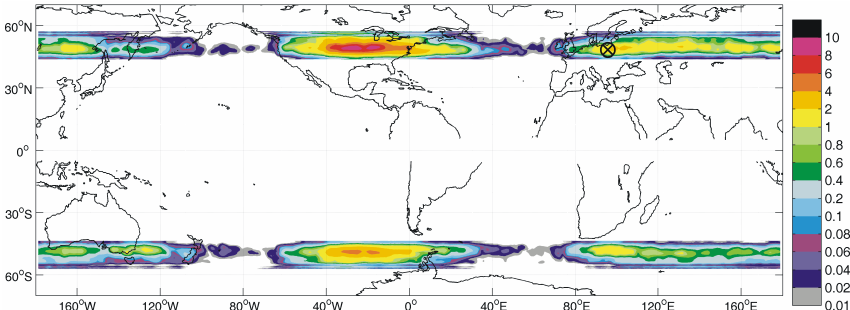
Fig. 1. Map showing the expected global distribution of energy flux deposited by WEP into the atmosphere in CGM coordinates, in units of 10 − 5 ergscm − 2 s − 1 (after Rodger et al.,